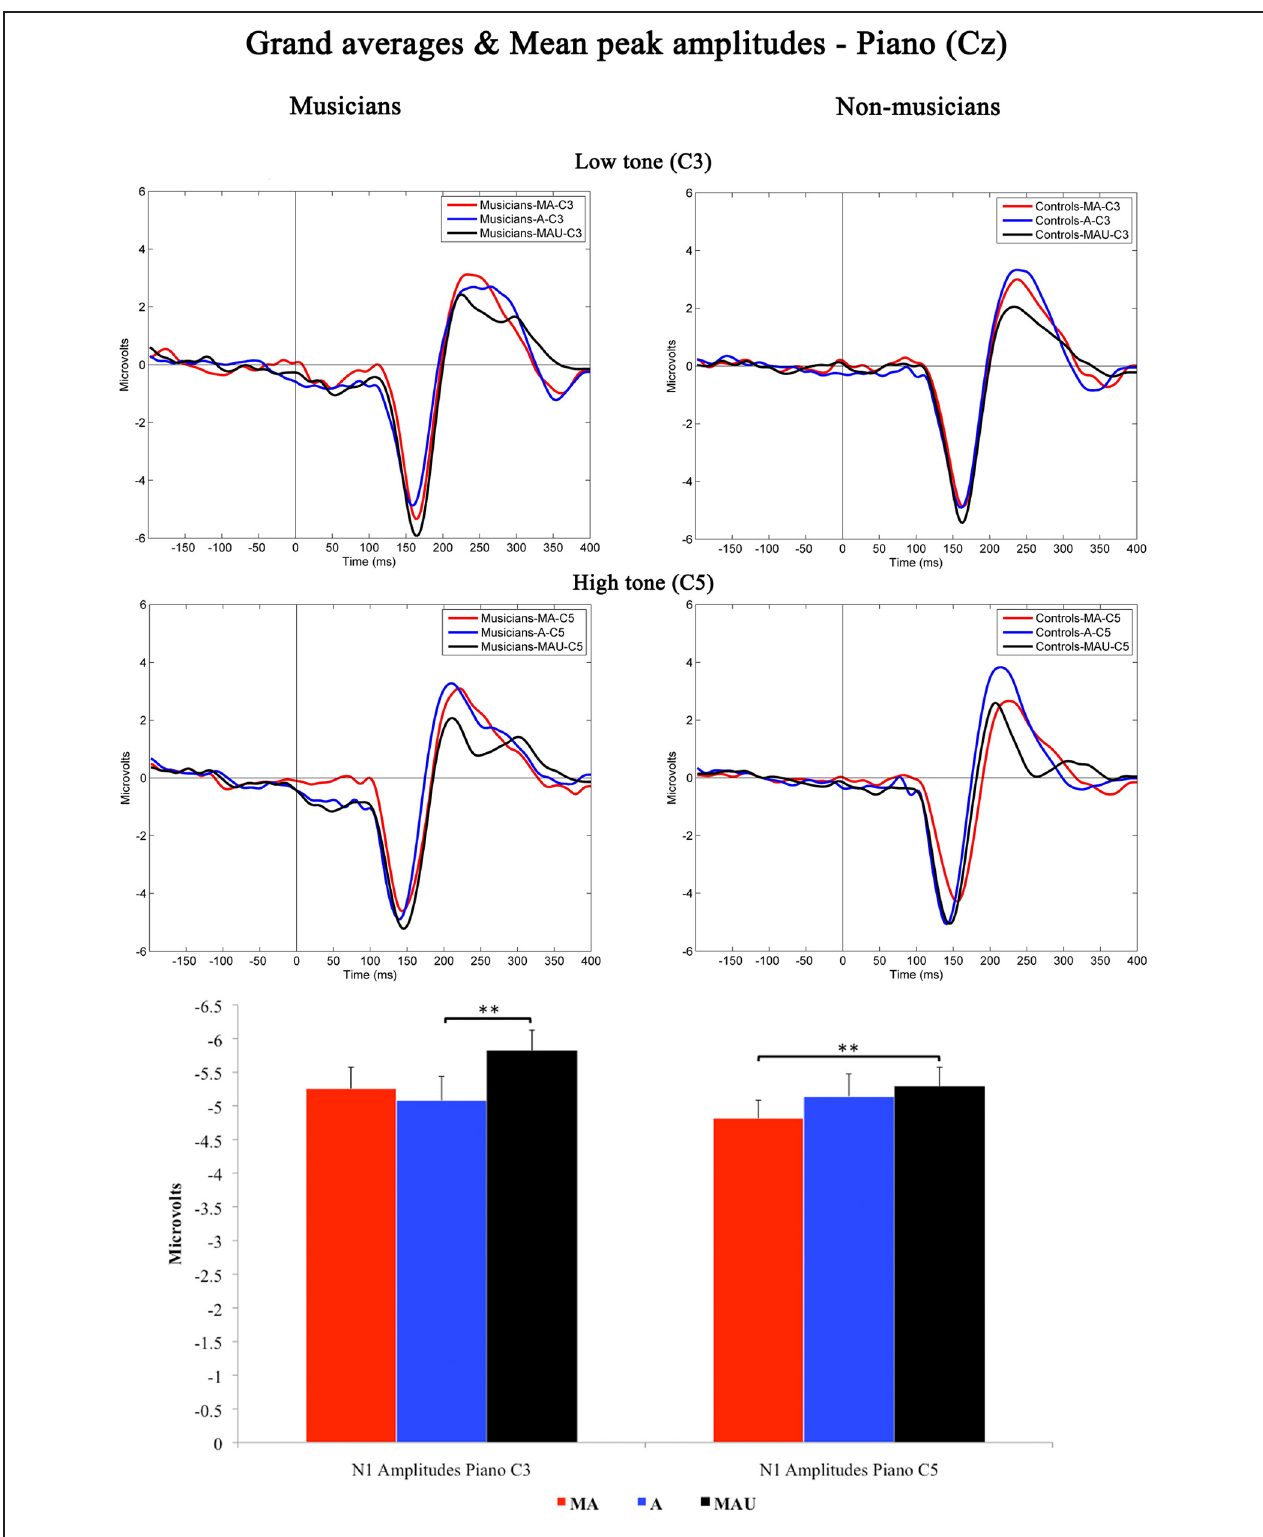
FIGURE 2 | Grand-averaged waveforms and correspondingmean N1 peak amplitudes evoked by low (top) and high (bottom) piano tones recorded at Cz for musicians (left) and non-musicians (right). MA, Motor-Auditory task; A, Auditory-Only task; MAU, Motor-Auditory unpredictable task. Mean